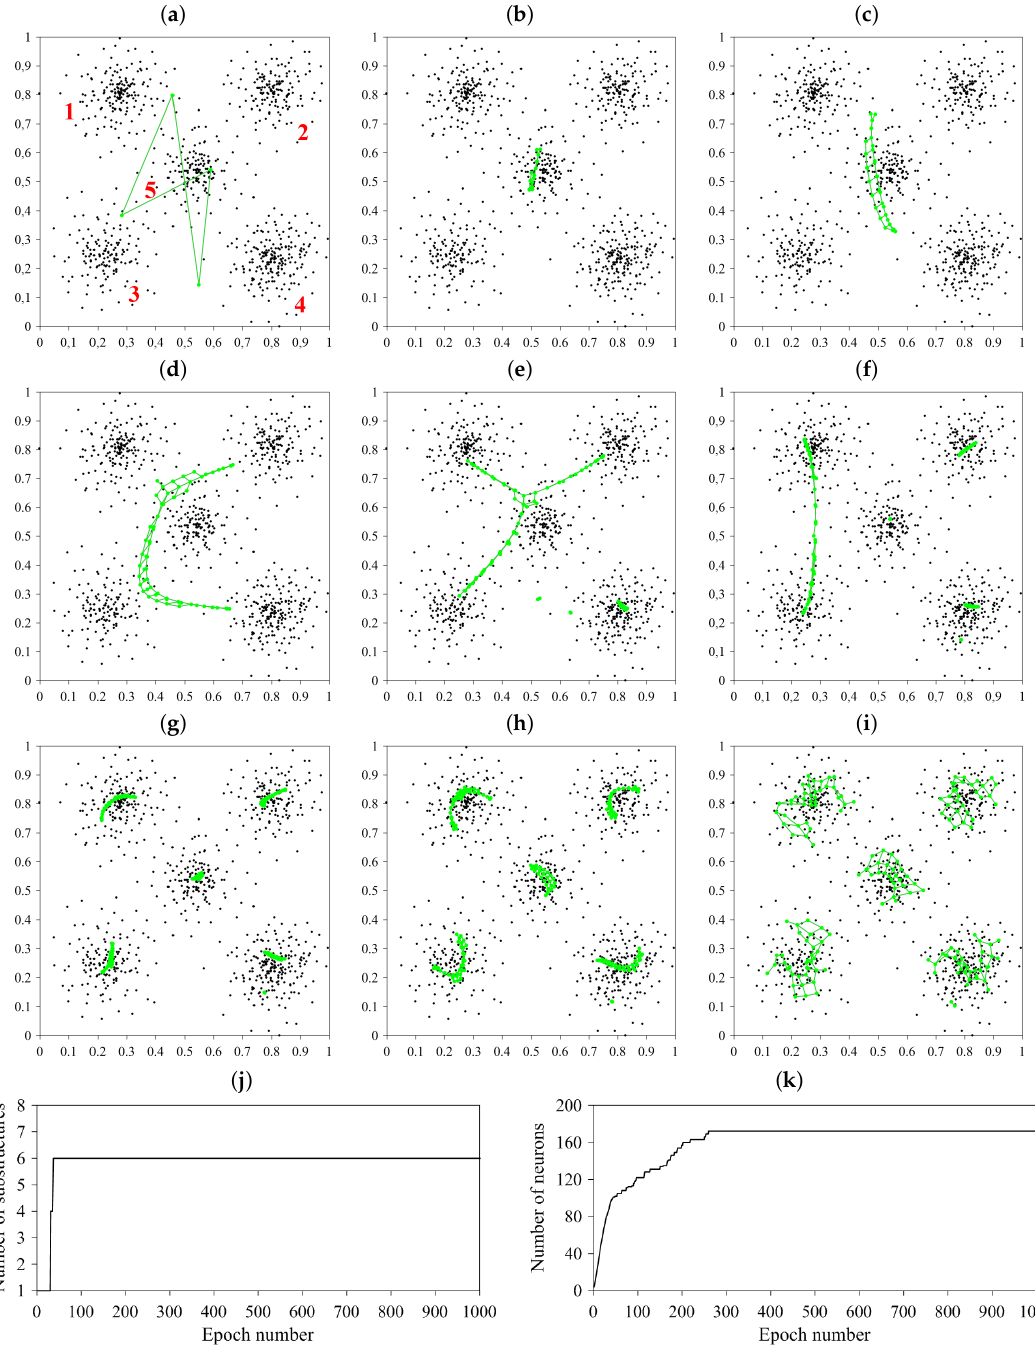
Figure 12. The evolution of Incremental Grid Growing (IGG) in the synthetic data set of Figure 5a in learning epochs: ( a ) No. 0 (start of learning), ( b ) No. 5, ( c ) No. 10, ( d ) No. 20, ( e ) No. 30, ( f ) No. 50, ( g ) No. 100, ( h ) No. 500, and ( i ) No. 1000 (end of learning) as well as plots of the number of substructures ( j ) and the number of neurons ( k ) vs. epoch